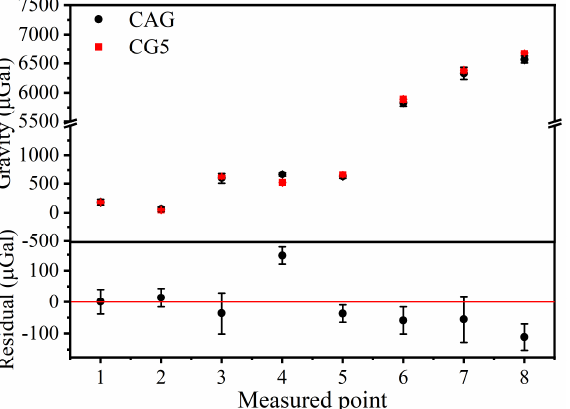
Figure 7. The gravity data of 8 measured points with home-made, truck-borne CAG system and the relative gravimeter of CG-5 (the black and red dots represent the results of CAG and CG-5, respectively); the residuals data between them are also shown in the figure below.